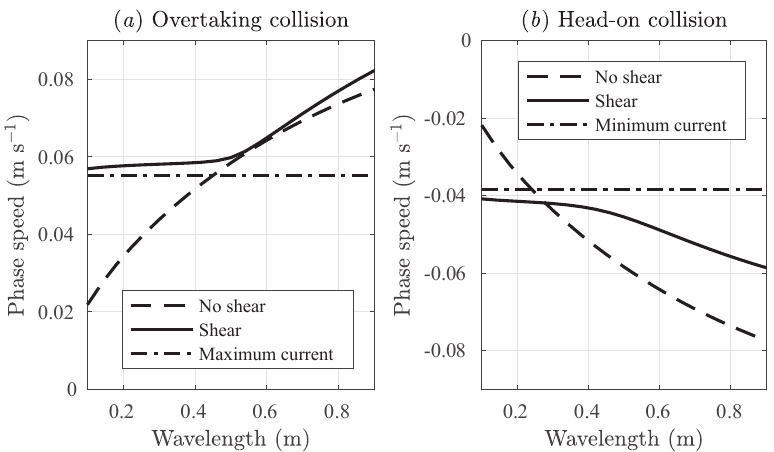
Figure 10. Phase speed of mode-1 linear waves in the ISW-induced background shear current (solid curves) and a hypothetical zero- background current (dashed curves) for (a) overtaking and (b) head-on collisions as a function of wavelength. Dot-dashed lines indicate the maximum (minimum) ISW-induced current.